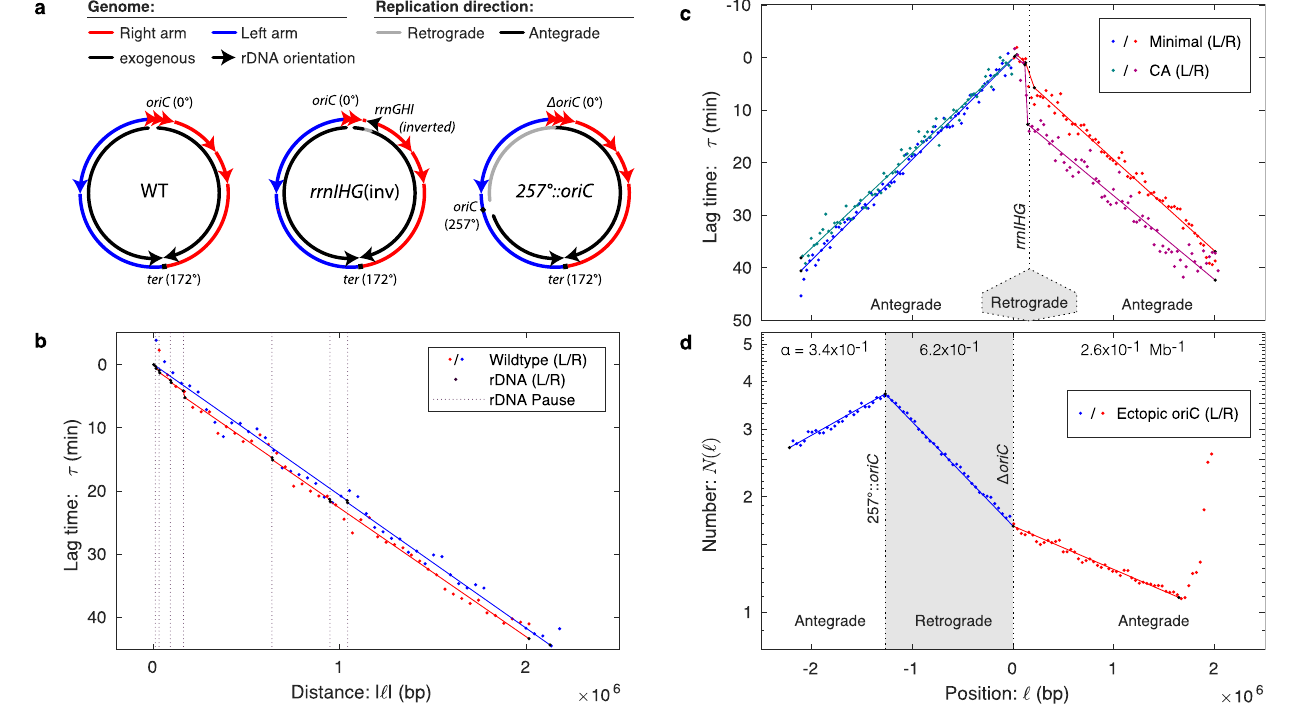
locus. In Model 4, fork velocities are constant and unequal on the left and right arms with equal-duration pauses at each rDNA locus. AIC